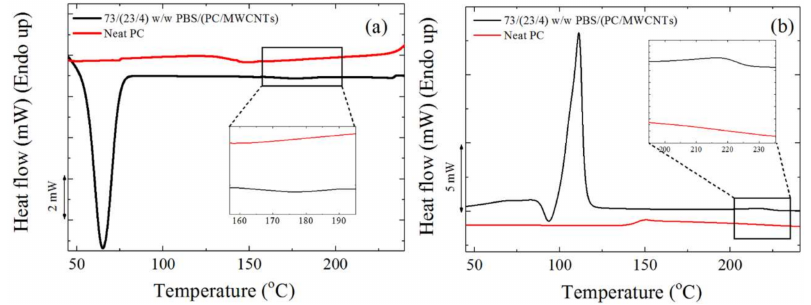
Figure 1. DSC ( a ) cooling and ( b ) second heating curves for neat polycarbonate (PC) and the 73/(23/4) w / w PBS/(PC/MWCNTs) nanocomposite. The zoomed regions correspond to the crystallization (see ( a )) and melting (see ( b )) of PC in the nanocomposites and its absence in the neat